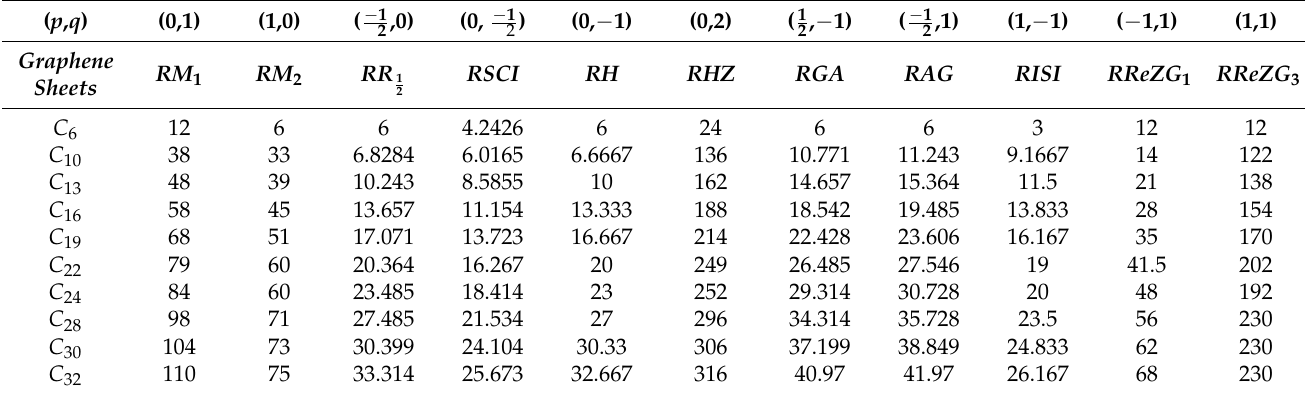
Table 3. Values of the reverse topological descriptors from C 6 to C 32.